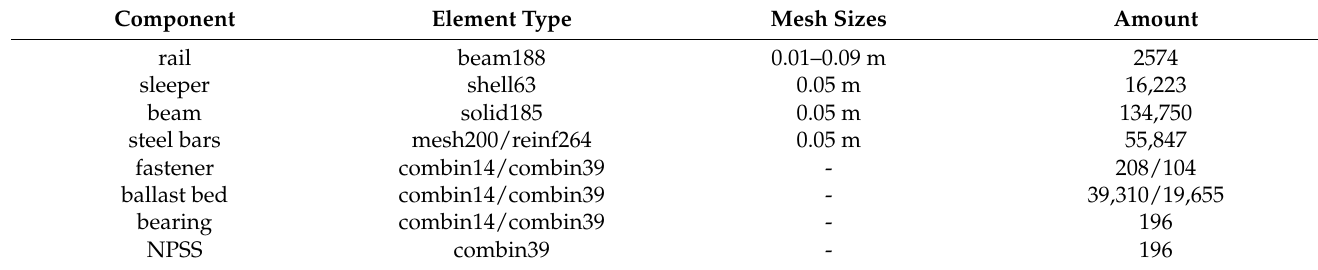
Table 1. Information of the model.